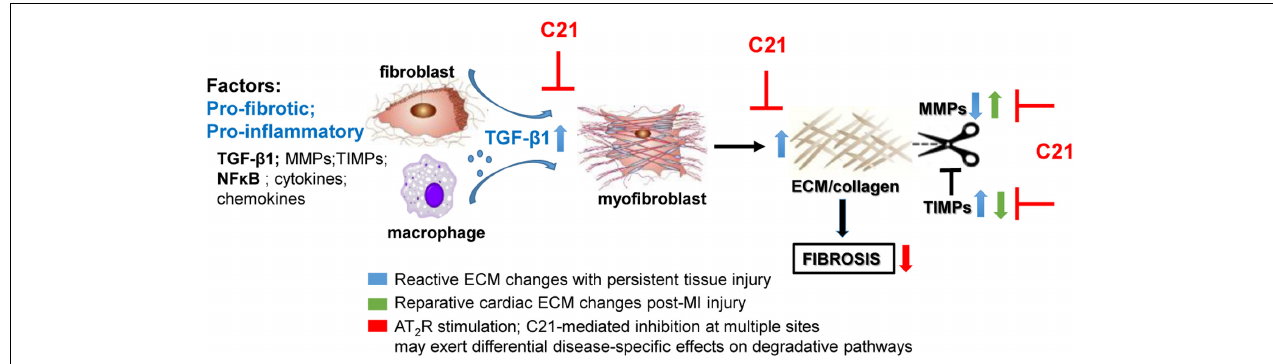
FIGURE 1 | Potential mechanisms involved in the anti-fibrotic actions of AT 2 R stimulation based on the effects of C21 (inhibitory sites in red). AT 2 R stimulation consistently reduces inflammatory and pro-fibrotic factors such as TGF- β 1 thereby inhibiting myofibroblast differentiation and ECM production. However, the effects of AT 2 R stimulation on ECM turnover may differ depending on the type of fibrosis/disease model studied. C21 inhibited the proteolytic left ventricular expansion associated with MI-induced injury (green arrows) whereas AT 2 R stimulation is more likely to inhibit ECM preservation (blue arrows) associated with persistent injury (e.g., hypertension), thus facilitating ECM